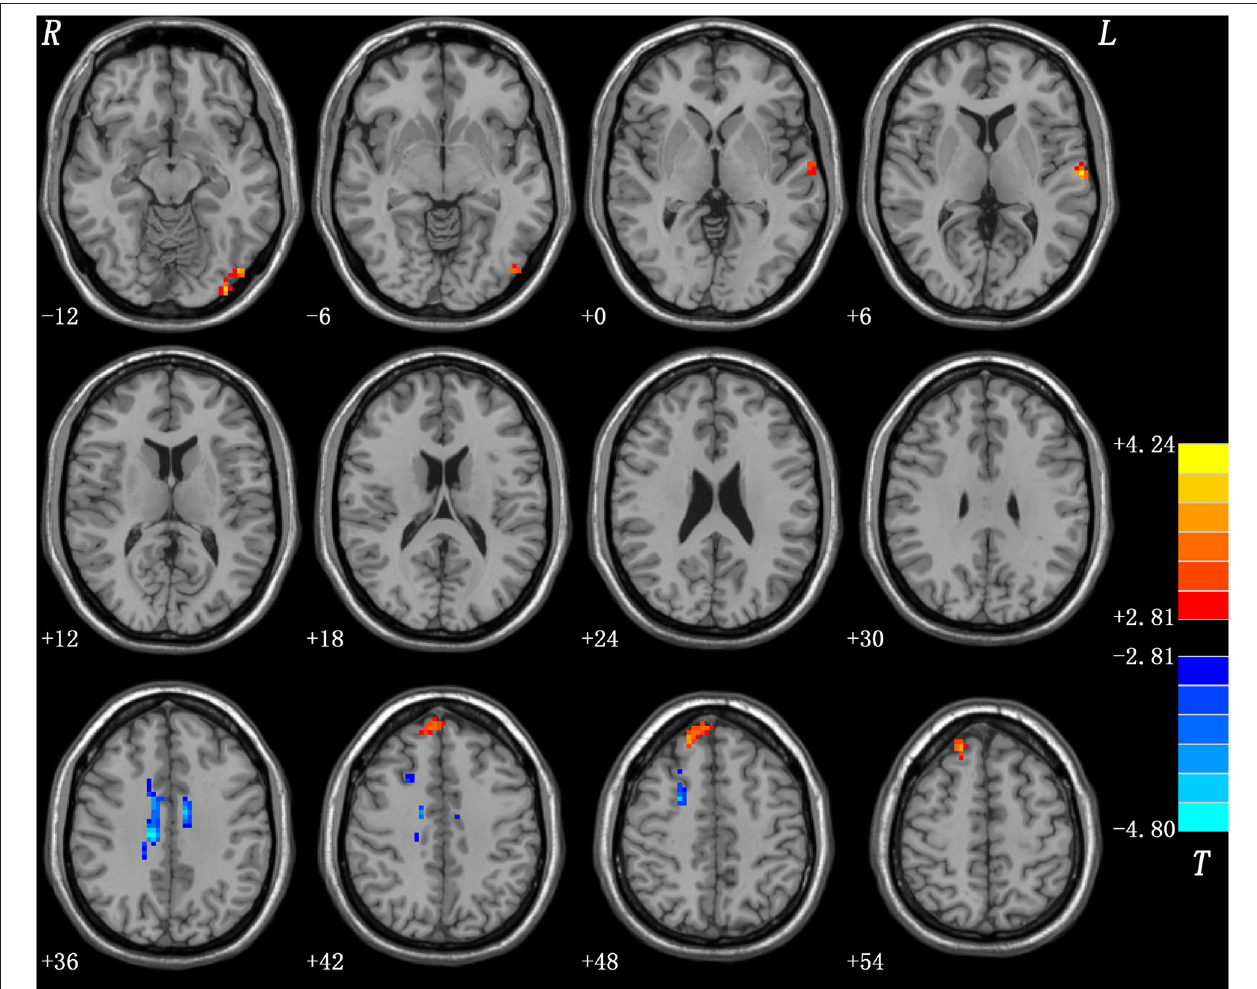
FIGURE 1 | Regions with abnormal ReHo in patients with DED. Red and blue denote increased and decreased ReHo in patients with DED, respectively. DED, dry eye disease; ReHo, regional